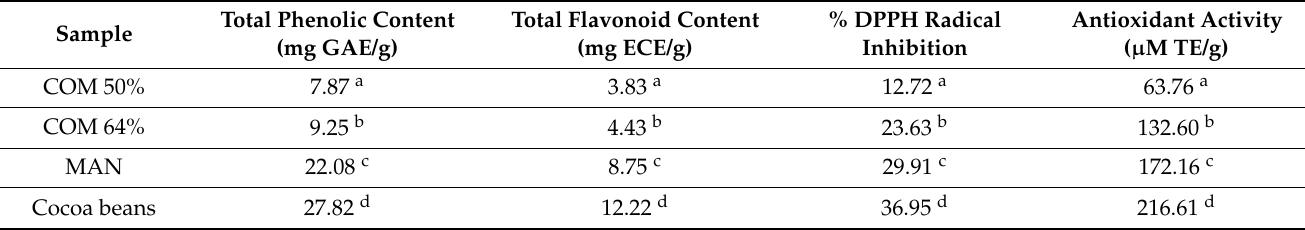
Table 3. Total phenolic content, total flavonoid content, and antioxidant activity of the analysed samples of raw chocolate, commercial chocolates, and cocoa